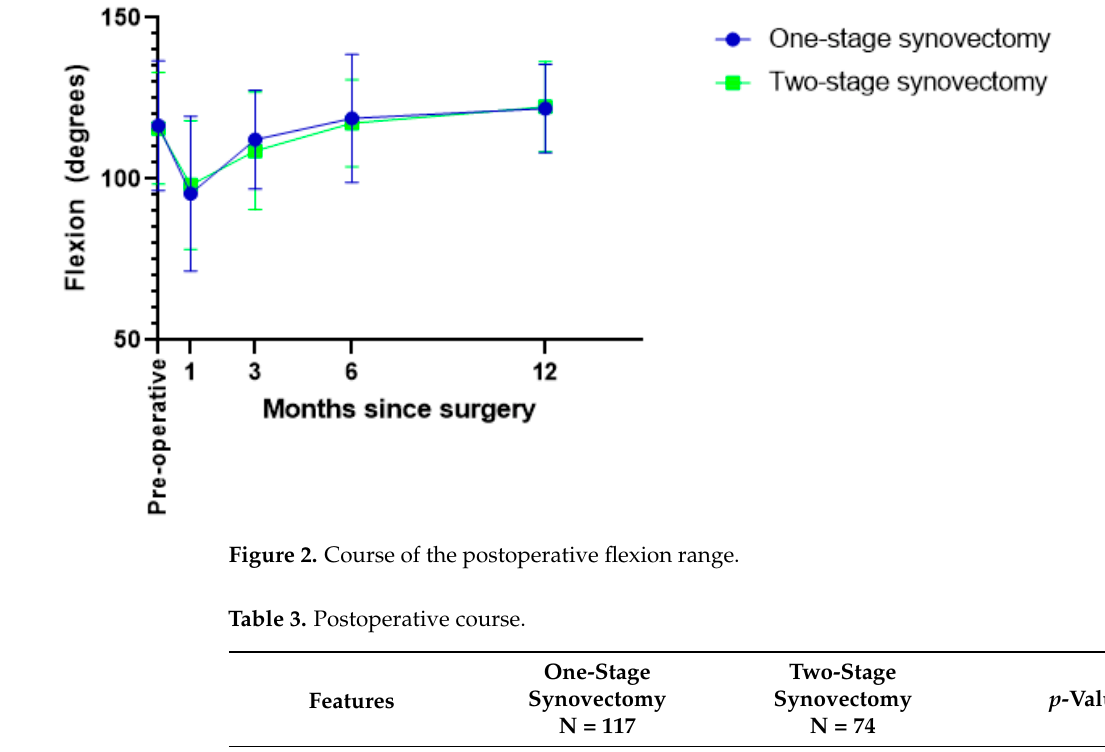
Table 3. Postoperative course.